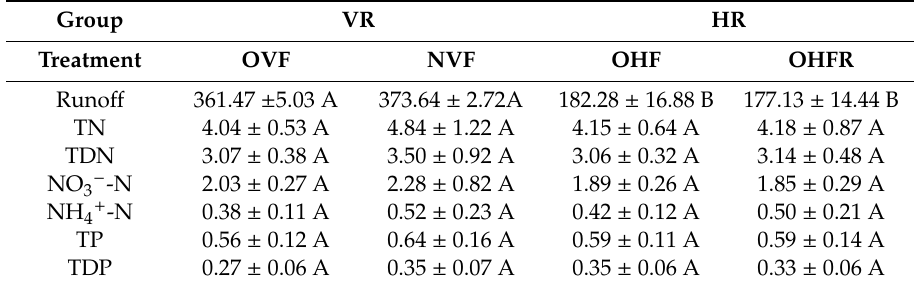
Table 4. Runo ff and concentration of nitrogen and phosphorus loss in runo ff during 2014–2017. Group